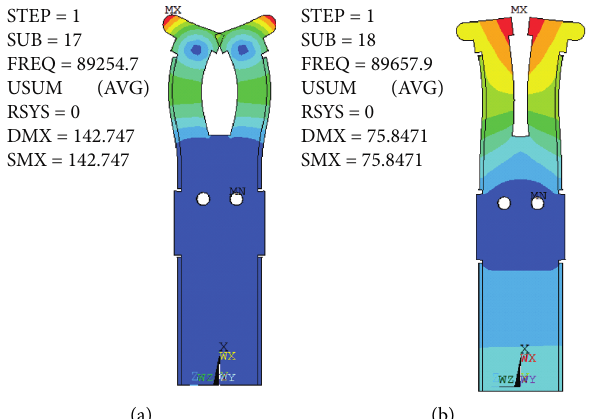
Figure 8: Modes of stator with all DOF. (a) Partial second-order bending vibration mode. (b) Global first-order longitudinal vibration mode.